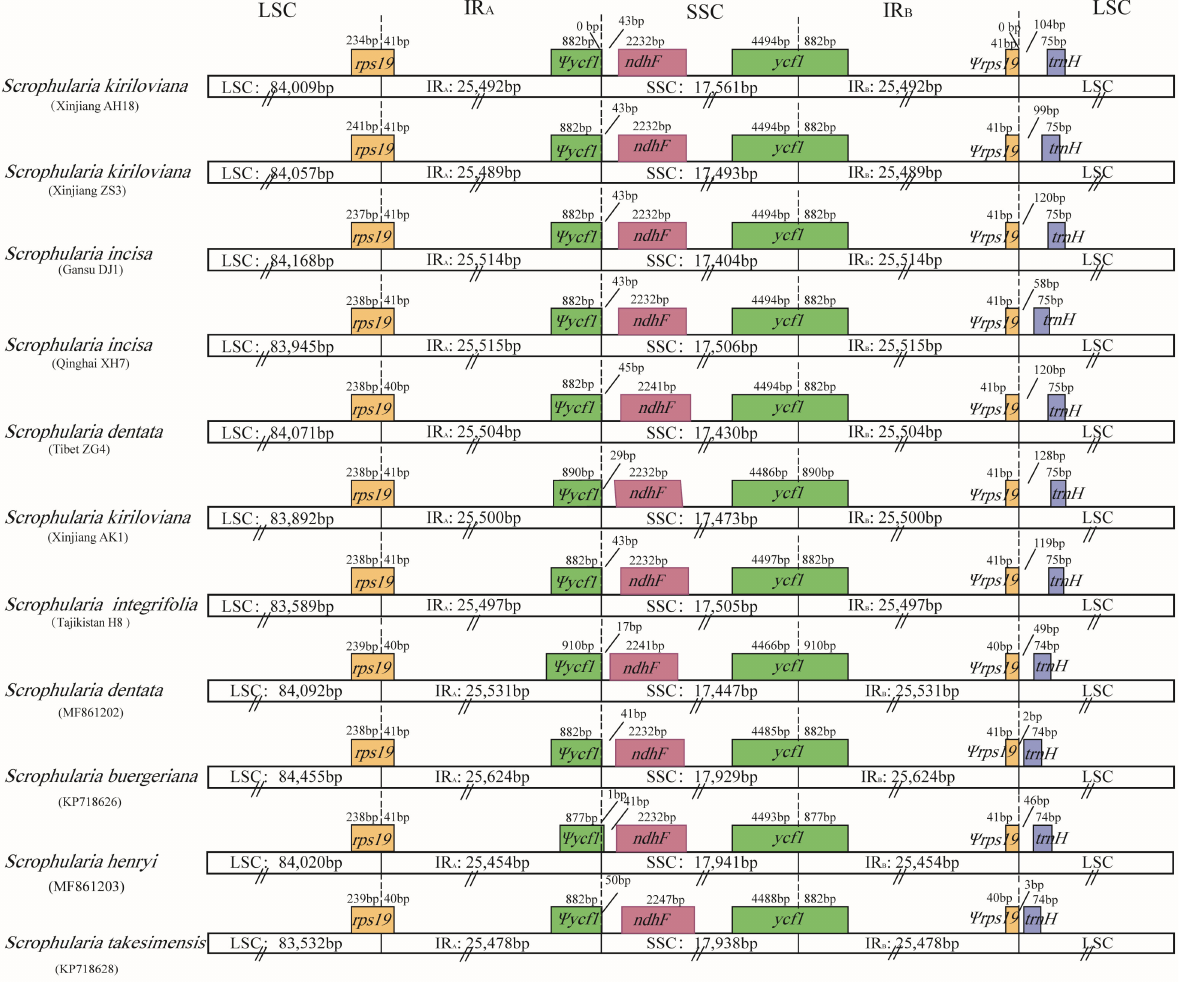
Figure 3. Comparison of LSC, IR and SSC junction positions among Scrophularia